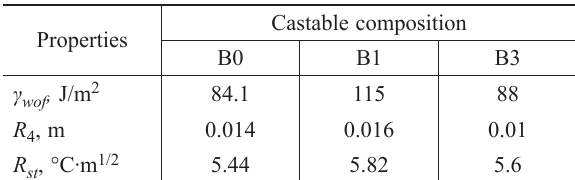
Fig. 3. Burning of additives CF and